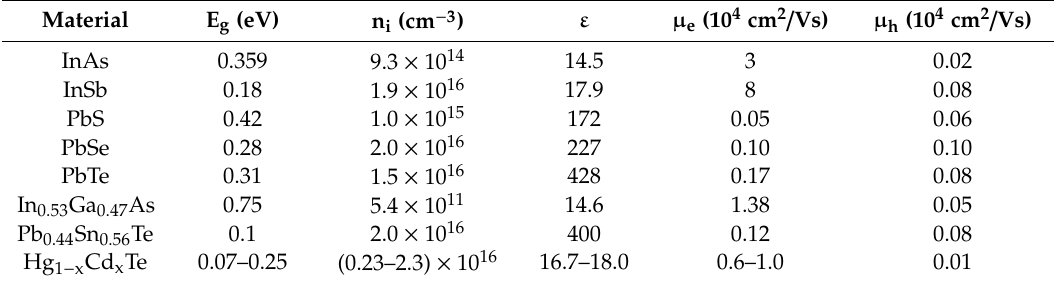
Table 1. Some physical and optical properties at room temperature of narrow gap semiconductors [15].